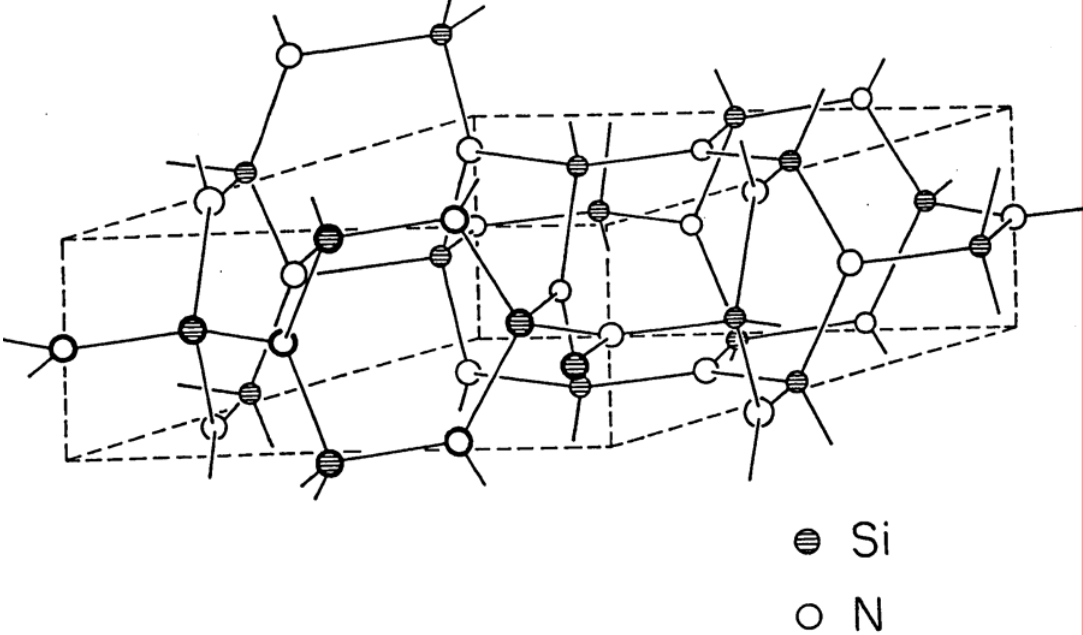
Figure 8. Phenacite